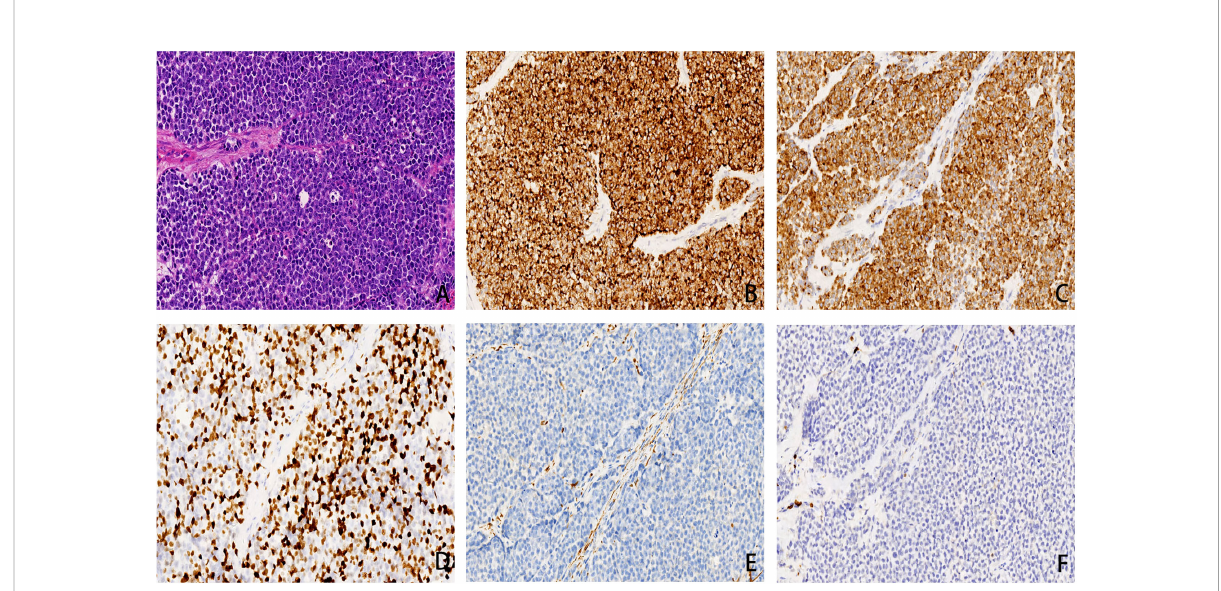
FIGURE 1 (A) small round cells was diffusely distributed, cellular atypia and nucleus to cytoplasm ratio were relatively high, conspicuous nucleoli and pathological nuclear division can be detected(×200 hematoxylin/eosin). (B) HMB45 was diffusely positive in cytoplasm, with a speci fi city of 100% and a sensitivity of 93%(×200 hematoxylin/eosin). (C) Melan-A is a marker of melanin differentiation with high sensitivity and speci fi city in malignant melanoma. In this case, Melan-A was diffuse positive in cytoplasm(×200 hematoxylin/eosin). (D) Ki67 can distinguish benign and malignant melanomas and can mark the maturation of melanin lesions. The positive cells in malignant melanomas were generally > 25%, in this case it is about 40%(×200 hematoxylin/eosin). (E) CK is a broad-spectrum epithelial marker. In this case, CK is negative and is distinct from epithelial carcinoma (×200 hematoxylin/eosin). (F) LCA is a lymphocyte marker and is negative in this case, distinguishing it from lymphoma (×200